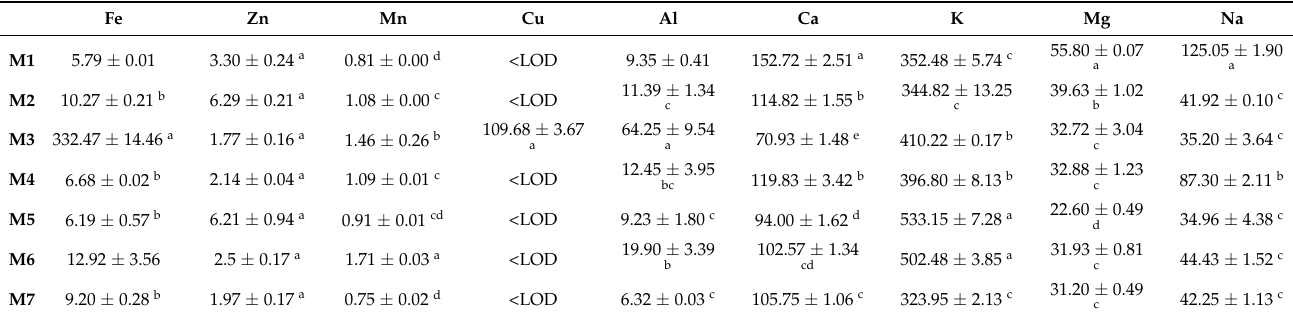
Table 4. Mineral content (mg/kg) in Moroccan Euphorbia honeys. E. officinarum (samples M1, M3, M4, M5, M7) and E. resinifera (samples M2, M6). * The results of M2 and M3 samples were previously published [13]. Reproduced with permission from Oumaima Boutoub et al., Antioxidant activity and enzyme inhibitory potential of Euphorbia resinifera and E. officinarum honeys from Morocco and plant aqueous extracts; published by Springer Nature, 2020.